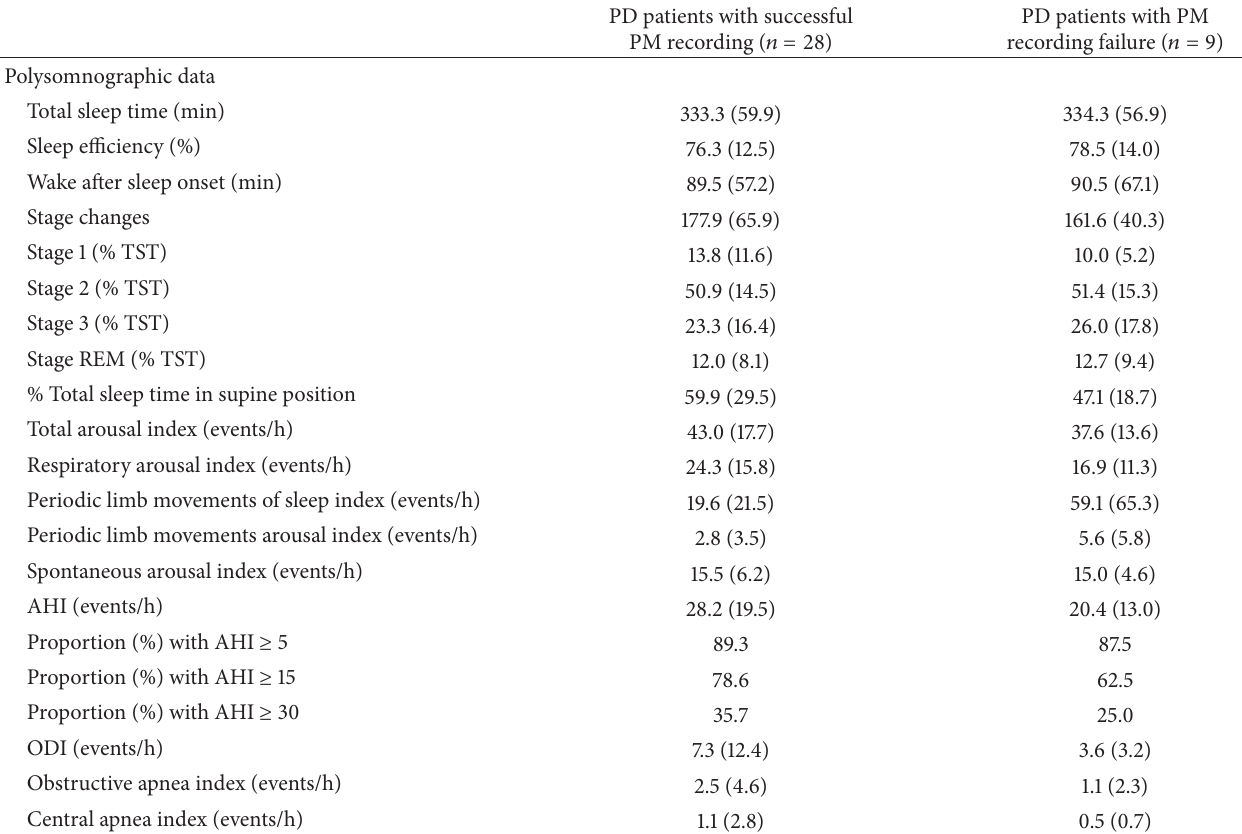
Table 2: Polysomnographic data.